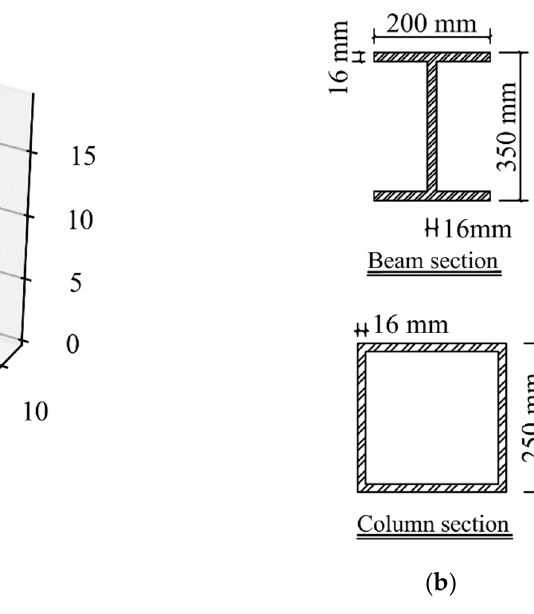
Table 2. Statistical properties of the structural parameters.